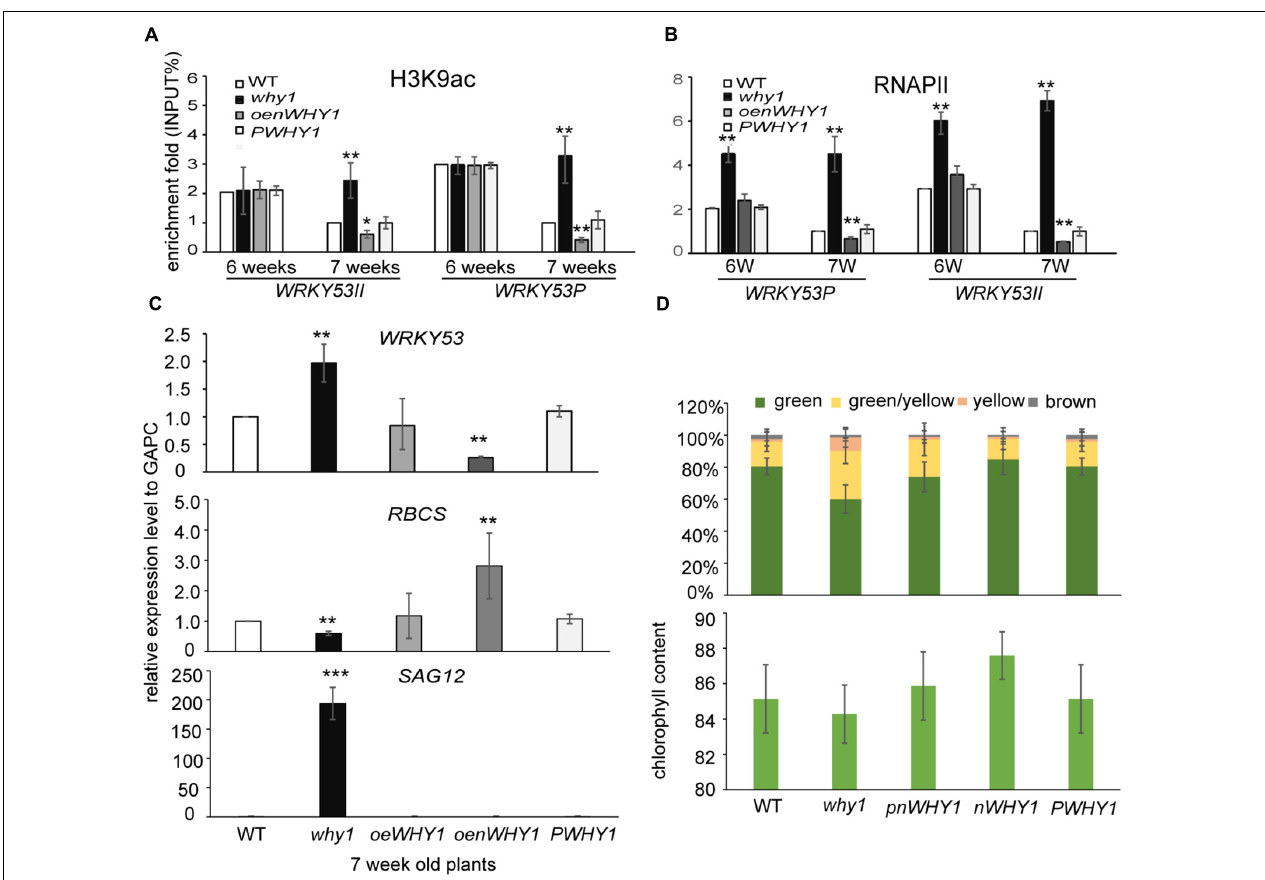
FIGURE 3 | WHIRLY1 enhances H3K9 deacetylation and represses RNAPII recruitment at WRKY53 at leaf early senescence stage. (A,B) ChIP experiments were performed to assess H3K9ac (A) and RNAPII occupancy (B) at WHIRLY1 binding region (WRKY53II) and translation start region (WRKY53P) of WRKY53 using rosette leaves of why1 , oenWHY1 , wild-type (WT), and PWHY1 plants. The relative level (input %) was normalized to that of 5-week-old WT. Three biological replicates and three technique replicates were used to analyze. Error bar shows the SD ( n = 3 × 3). Asterisk indicate significant differences ( ∗ P < 0.05 and ∗∗ P < 0.01) based on Student’s t -test. (C) Expression of senescence-associated genes in 7-week-old why1 , oenWHY1 , WT, and PWHY1 plants. The transcript level in each case was normalized to that of GAPC2 as a reference gene and the expression level of WT was set as 1. Three biological replicates and three technique replicates were used to analyze. Asterisk indicate significant differences ( ∗ P < 0.05, ∗∗ P < 0.01, and ∗∗∗ P < 0.001) based on Student’s t -test. (D) Senescent leaf fraction and chlorophyll content in 7-week-old why1 , oenWHY1 , WT, and PWHY1 plants. Mean and SD of at least 12 independent measurements are shown. Error bars represent